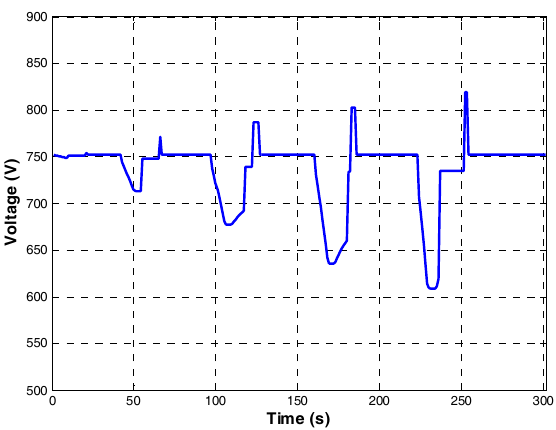
Figure 11. Voltage trend in the node 10 during the movement of the tram along the track.